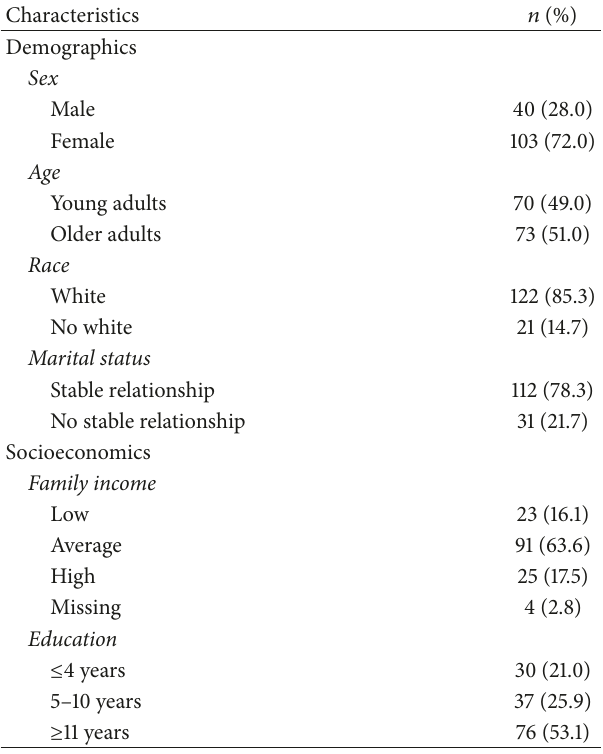
Table 1: Demographic and socioeconomic characteristics of sample of adults living in Piracicaba, S˜ao Paulo,